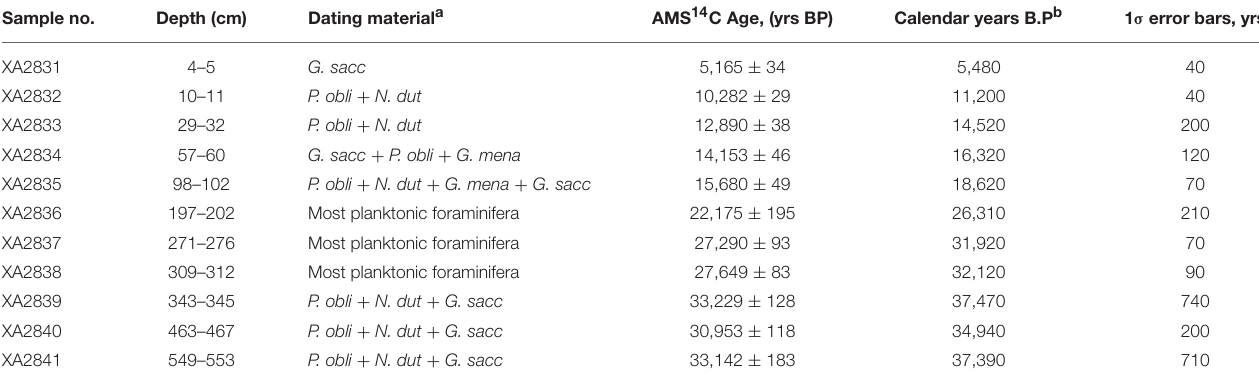
TABLE 1 | AMS14C age data for core NS07-25 (Xiang et al., 2009). Sample